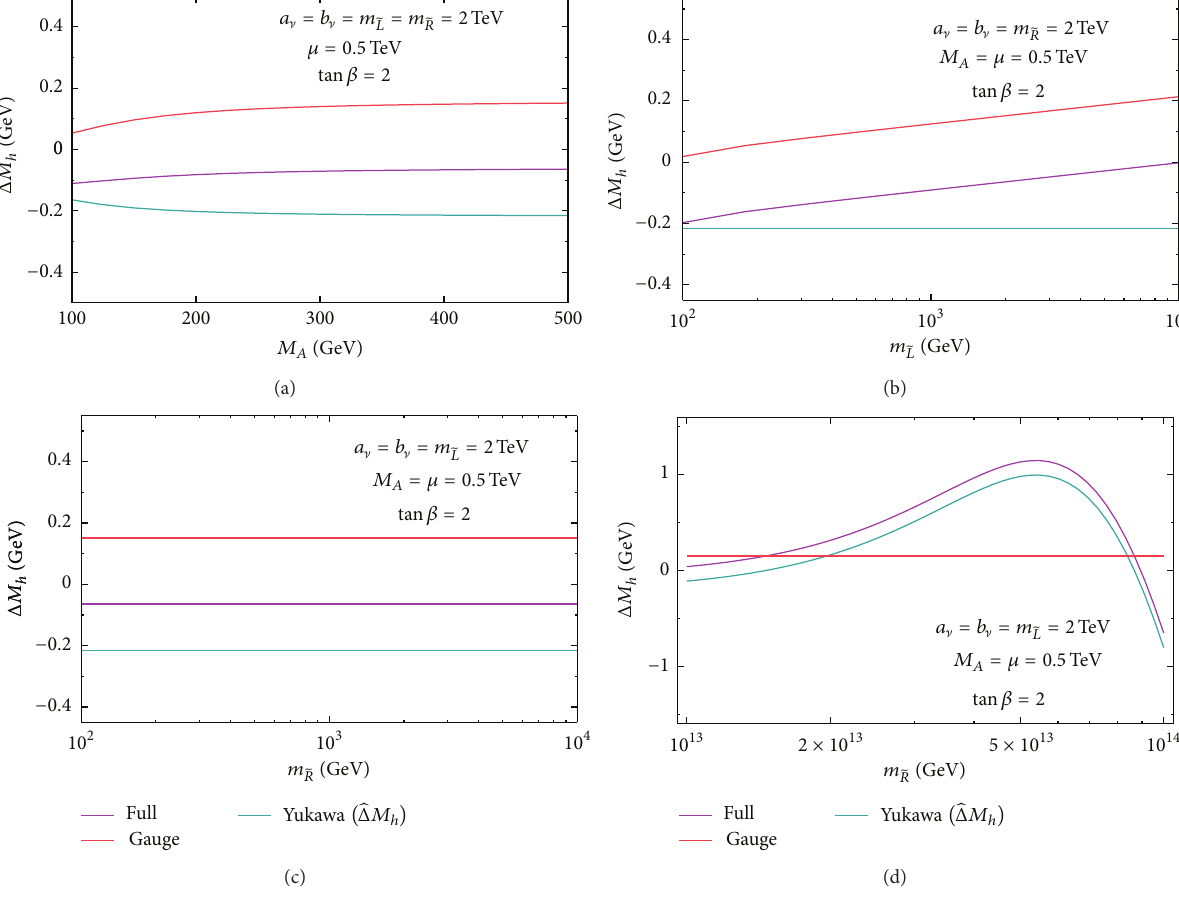
Figure 5: (a) Δ𝑀 ℎ as a function of 𝑀 𝐴 . (b) Δ𝑀 ℎ as a function of 𝑚 ̃𝐿 . (c) Δ𝑀 ℎ as a function of 𝑚 ̃𝑅 for low mass values 10 2 GeV < 𝑚 ̃𝑅 < 10 4 GeV. (d) Δ𝑀 ℎ as a function of 𝑚 ̃𝑅 for high mass values 10 13 GeV < 𝑚 ̃𝑅 < 10 14